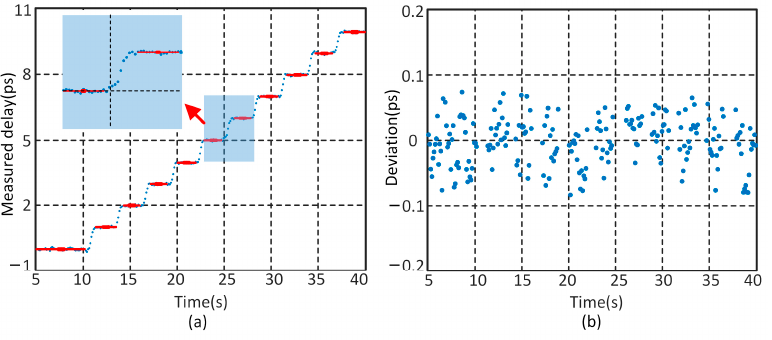
Figure 6. Measurement results when FTD varies with a step of 1 ps. ( a ) measured peak frequencies (red) and peak phases (blue); ( b ) the number of periods (red) and normalized phases (blue).